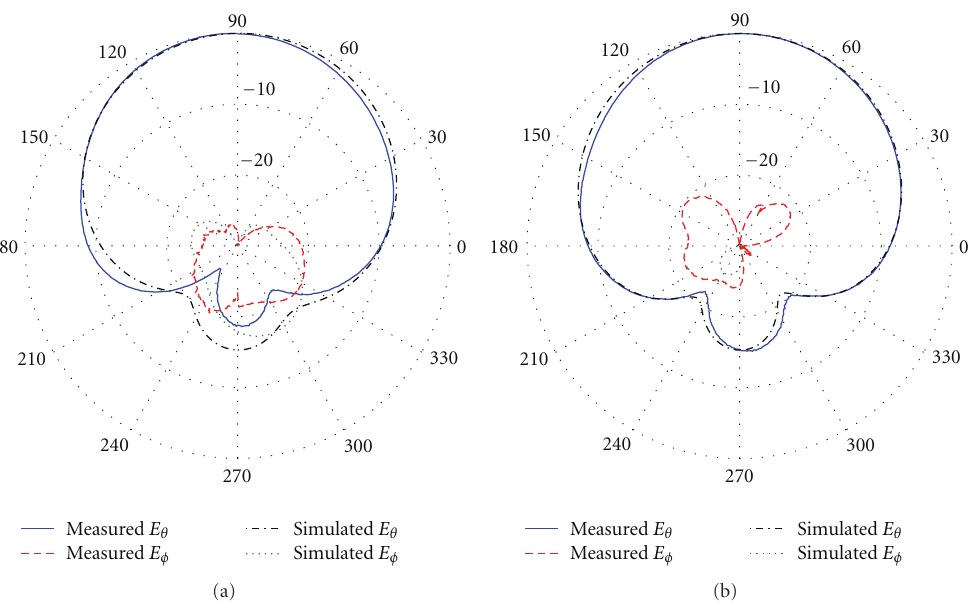
Figure 7: Simulated and measured radiation patterns for the HEM 11 δ mode at 2.6 GHz when the sum mode is activated (a) XZ plane (b) YZ plane, in dB